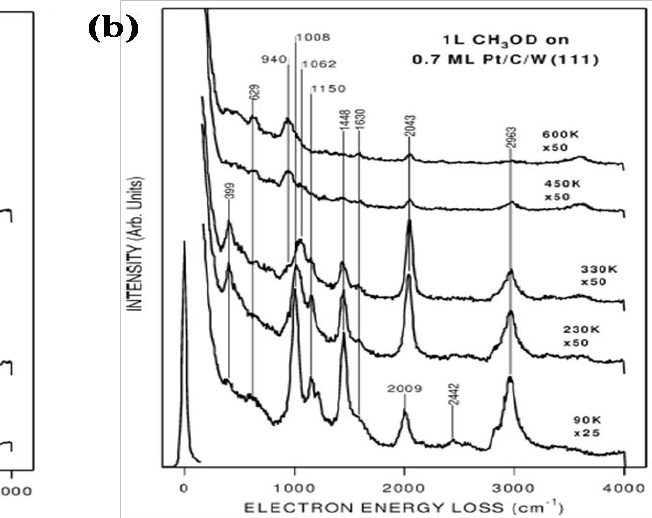
OD adsorbed on (a) 3